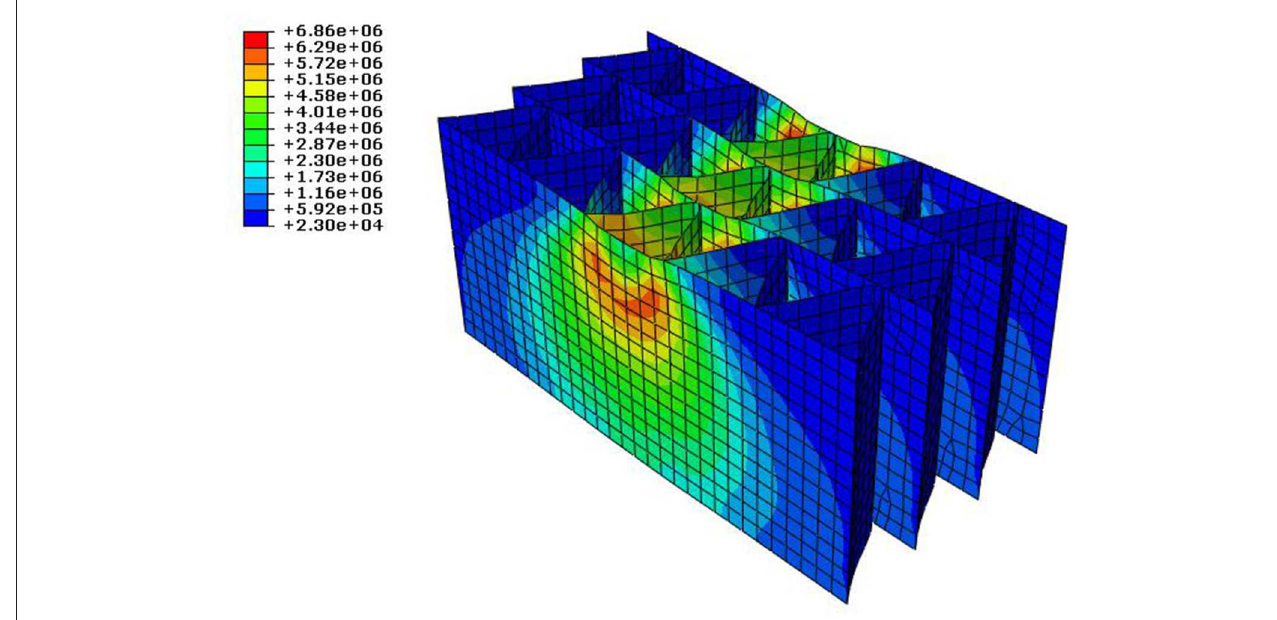
FIGURE 11 | Vertical stress (N/m 2 ) in geocell reinforcement (FEM data, s/B = 20%).